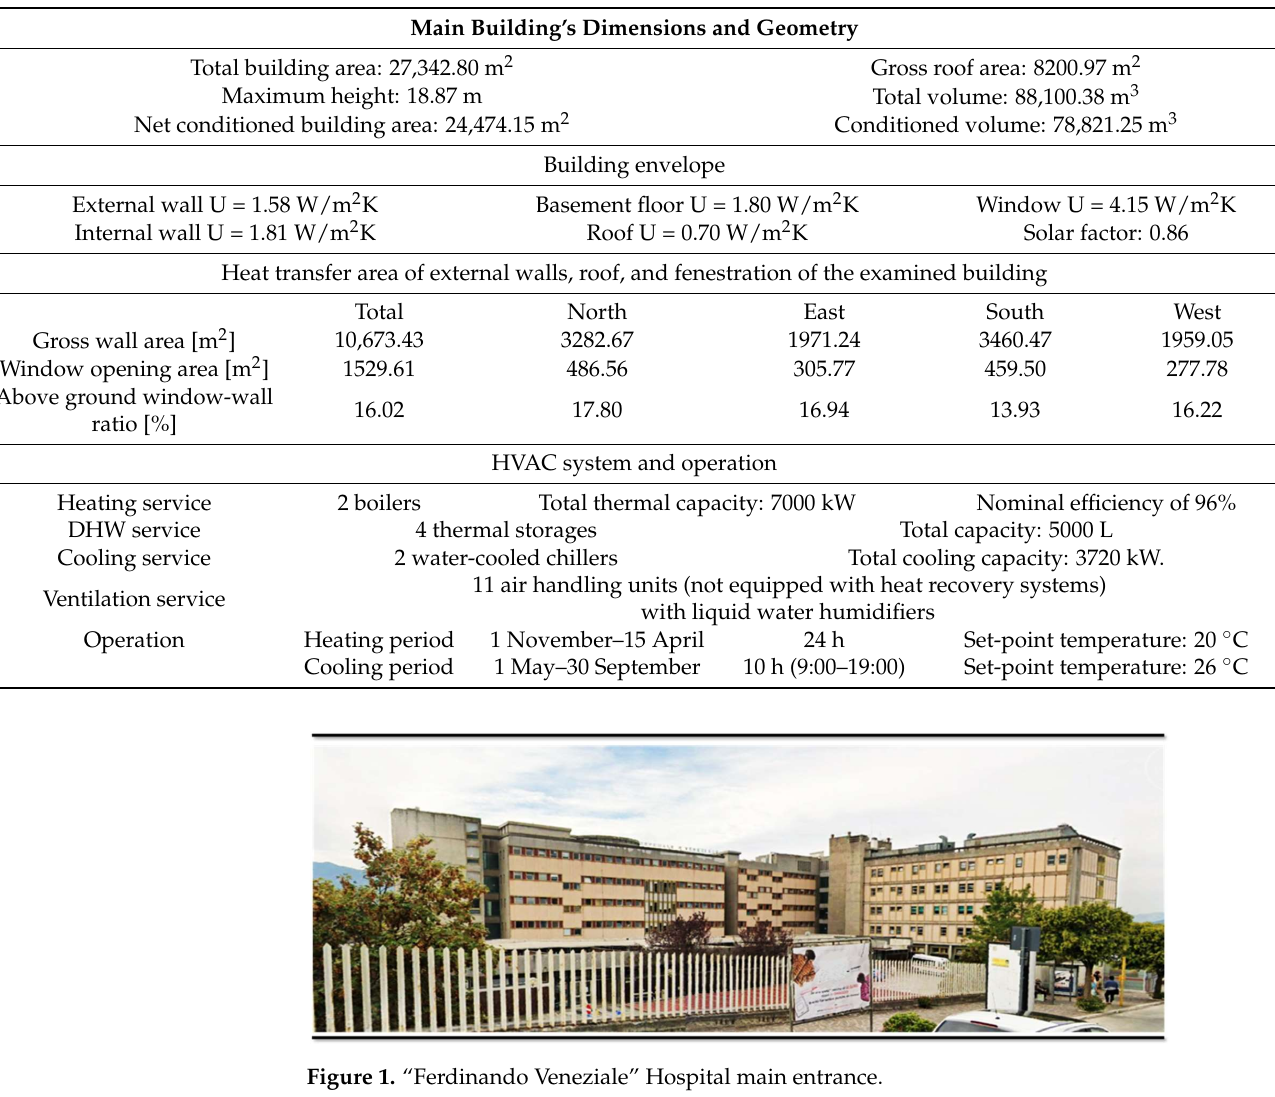
Figure 1. “Ferdinando Veneziale” Hospital main